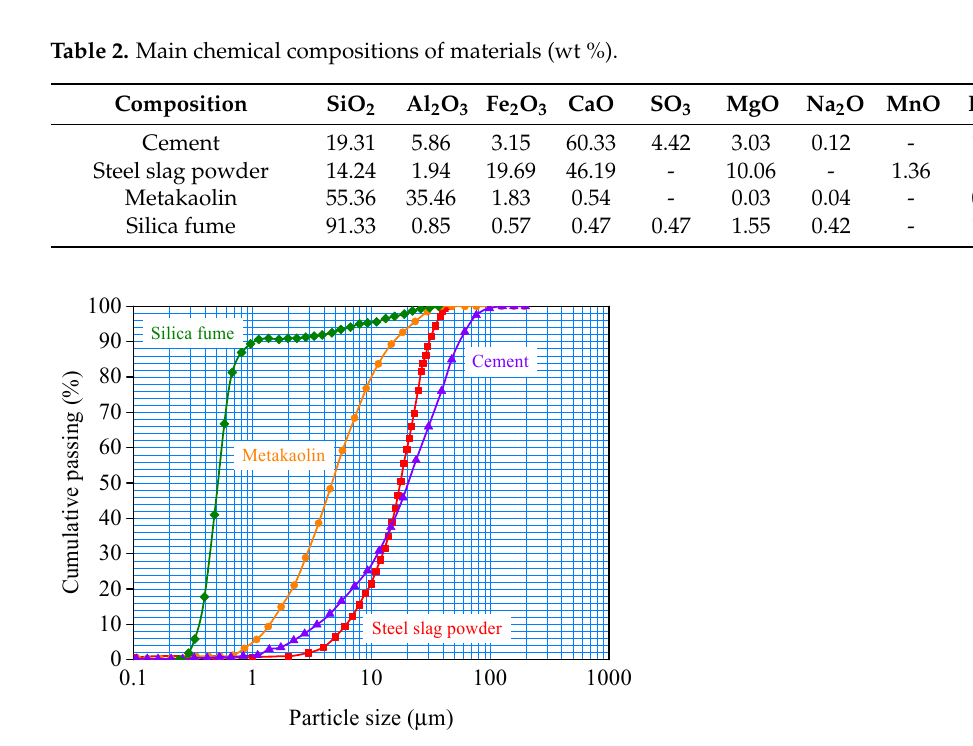
Figure 1. Particle size distribution of materials.